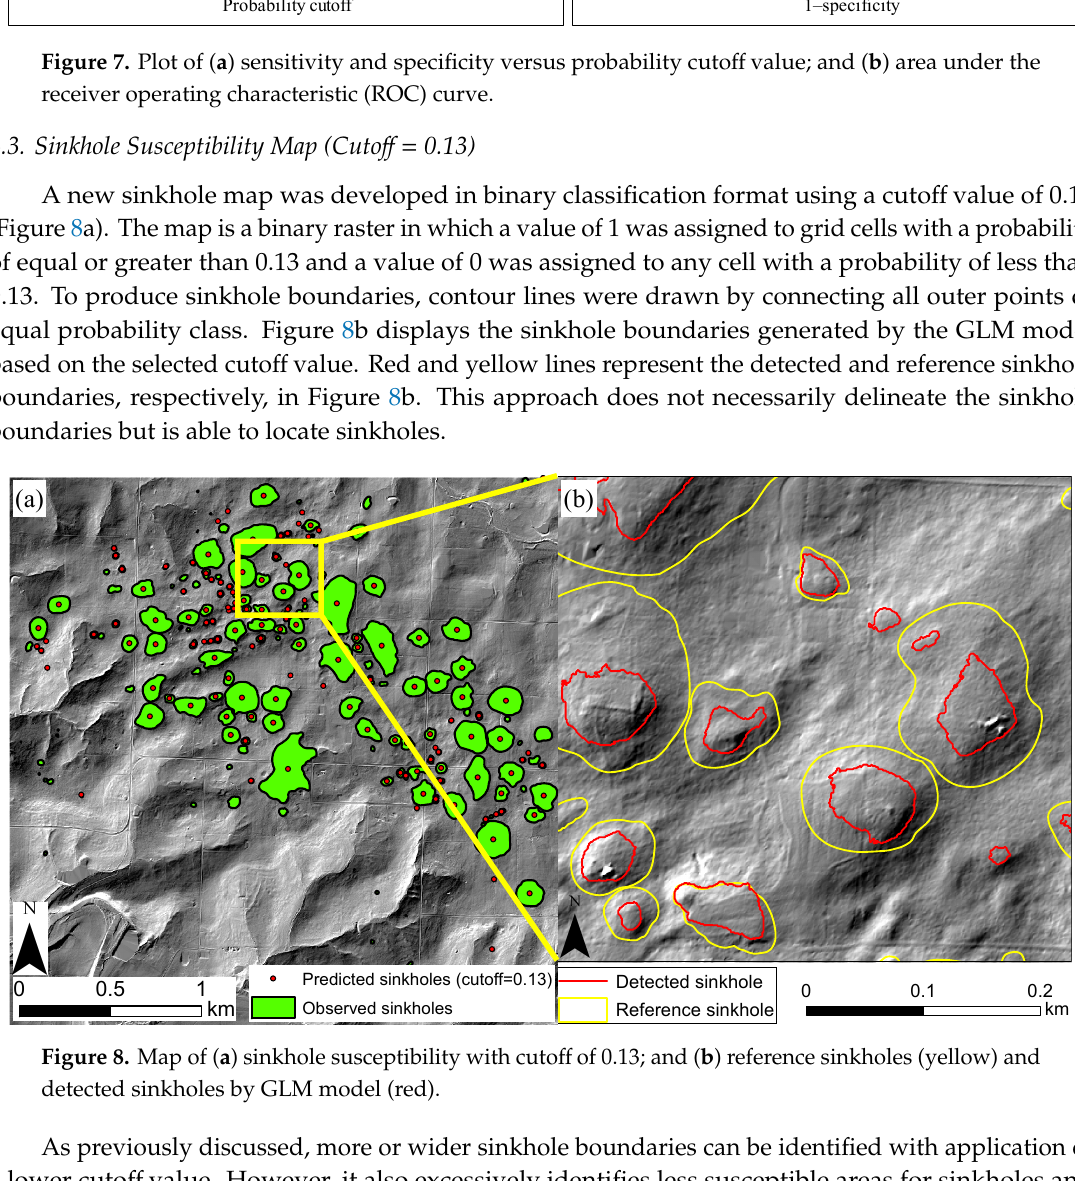
Figure 7. Plot of ( a ) sensitivity and specificity versus probability cuto ff value; and ( b ) area under the receiver operating characteristic (ROC) curve.